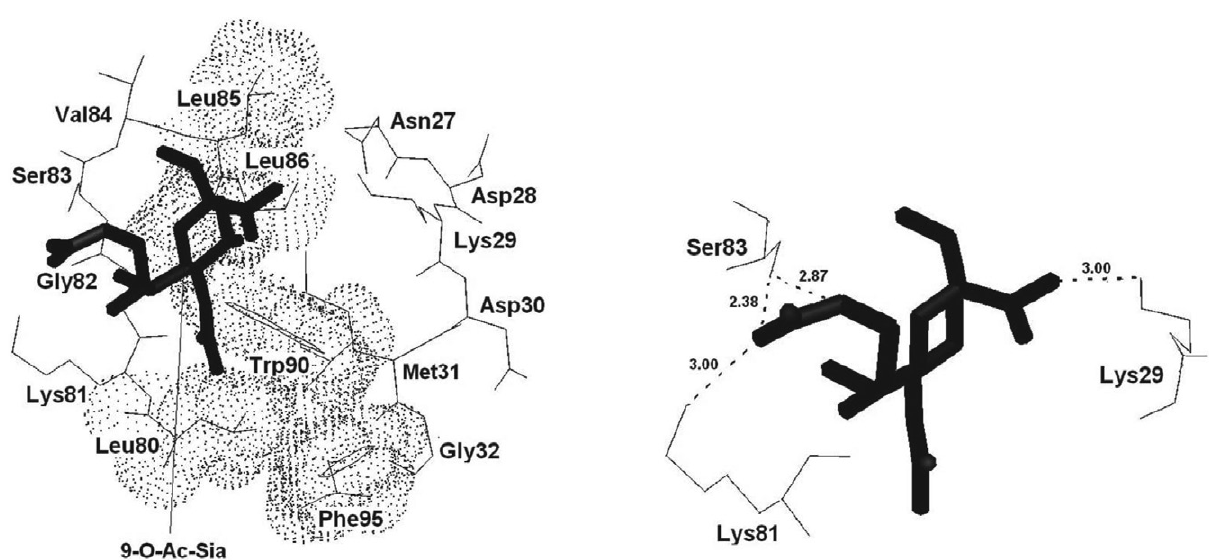
Figure 3. 9-O-Ac-Sia (bold sticks) that is docked in the binding site of the Thr31Met mutant of hCoV-OC43 S. The P2 (Leu80, Trp90 and Phe95) hydrophobic pocket (dots) accommodates the 5-N-acetyl methyl (left). 4 electrostatic contacts of 9-O-Ac-Sia with Lys29, Lys81, Ser83 and Ser83, respectively